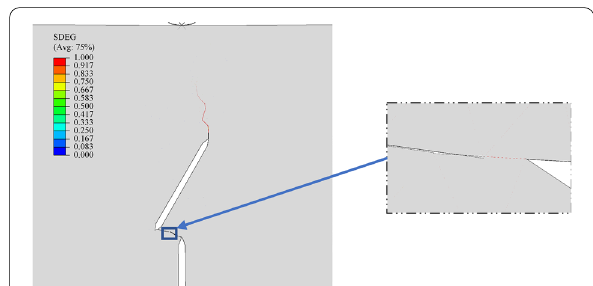
Fig. 20 SDV5 nephogram of model TPB‑A30‑T1N